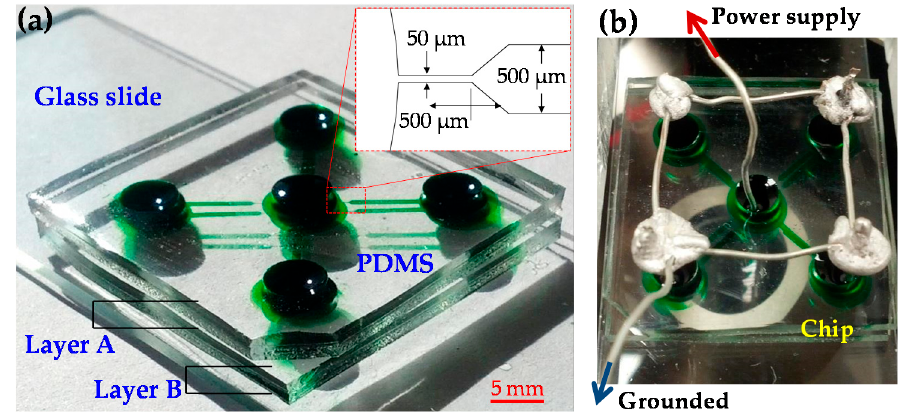
Figure 1. ( a ) Picture of the stacked PDMS/glass microfluidic device (reservoirs and microchannels are filled with green food dye for clarity) used in experiments, which consists of two PDMS layers with four 5-mm-long straight rectangular microchannels each; ( b ) Electrical connections for the stacked microfluidic device.